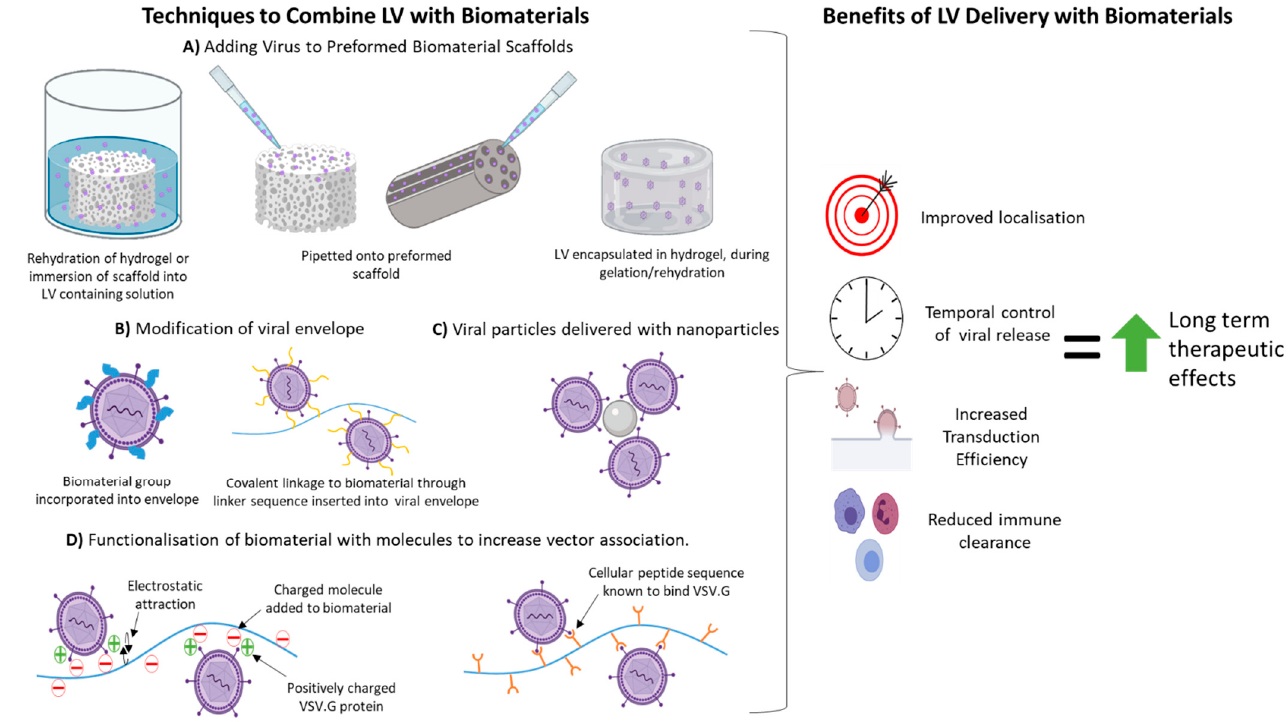
Figure 1. Techniques to Combine Lentiviral Vectors with Biomaterials and the Potential Benefits from such Combinations. ( A ) Lentiviral vector (LVs) particles have been added to biomaterial scaffolds via hydration of the scaffold in LV containing fluid or pipetting LVs directly onto the preformed porous or channel containing scaffolds. LVs can be incorporated into hydrogels prior to gelation. In these cases, LVs associate with the biomaterial in a non-specific manner unless the biomaterial has been modified before scaffold formation. ( B ) The viral envelope can be modified to incorporate a biomaterial molecule, or a molecular linker sequence can be added to allow covalent attachment of viral particle to a biomaterial. ( C ) Nanoparticles can non-covalently associate with LV particles. LV-nanoparticle complexes can be delivered on their own or incorporated into scaffolds pre- or post-formation. ( D ) Functionalisation of a biomaterial either pre- or post-scaffold formation with charged molecules or specific peptide sequences that increase the specific association of viral particles to biomaterials. Combining LVs with biomaterials can improve their localisation to the site of delivery, cause prolonged release of LVs into the environment and decrease immune clearance of LVs. All these effects increase transduction efficiency and transgene expression to enhance the efficacy of the LV therapy. This figure was created with the use of Biorender.com.